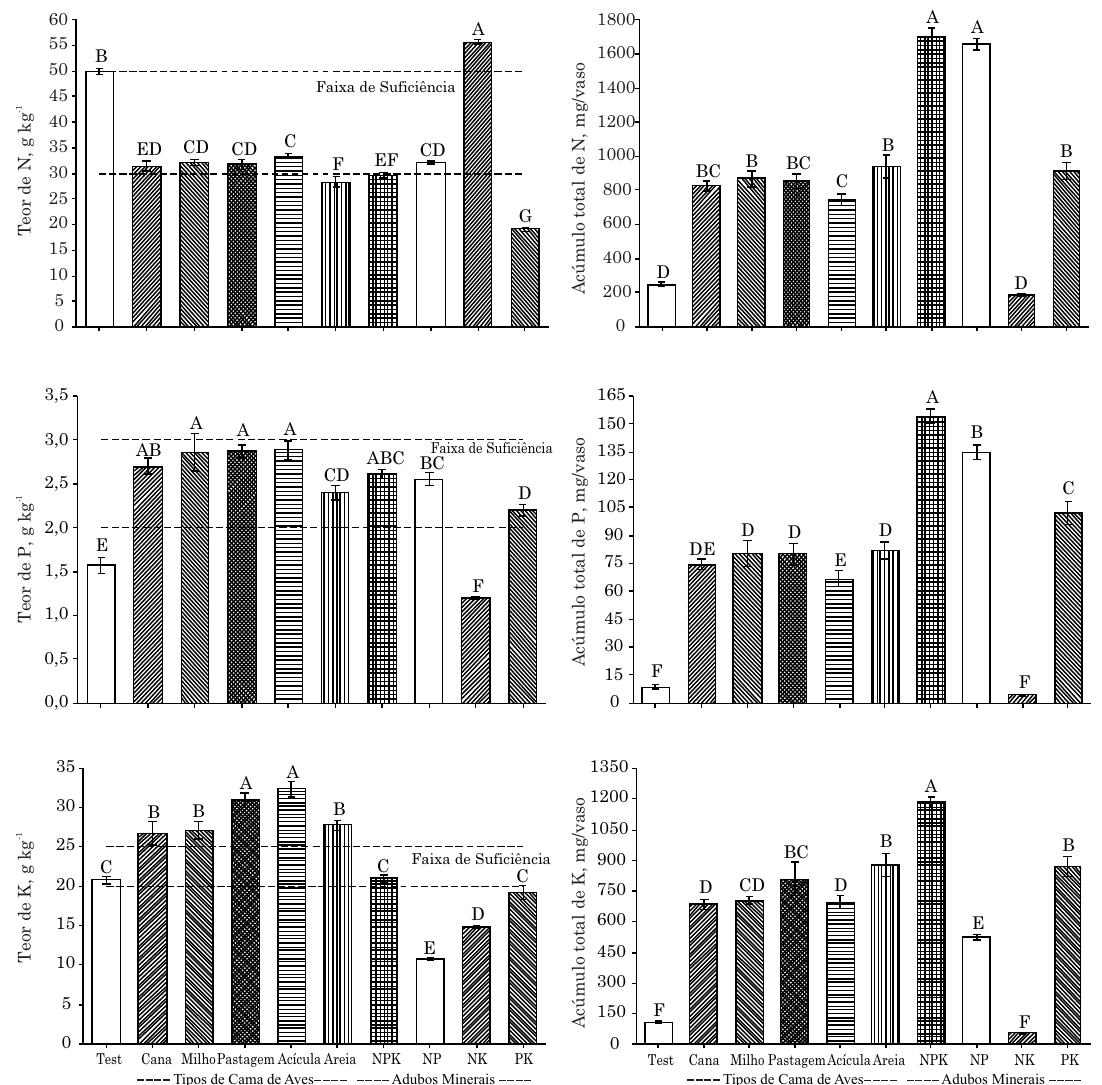
Figura 3. Teor e acúmulo totais de N, P e K na cultura do feijão, com 60 dias após a semeadura, em razão da adição de fontes orgânicas e minerais, em casa de vegetação. Barras nas colunas referem-se ao erro- padrão da média. Valores nas colunas de cada época de amostragem seguidos de mesma letra não diferem significativamente pelo teste da diferença mínima significativa (DMS) a 5 %. Test: tratamento